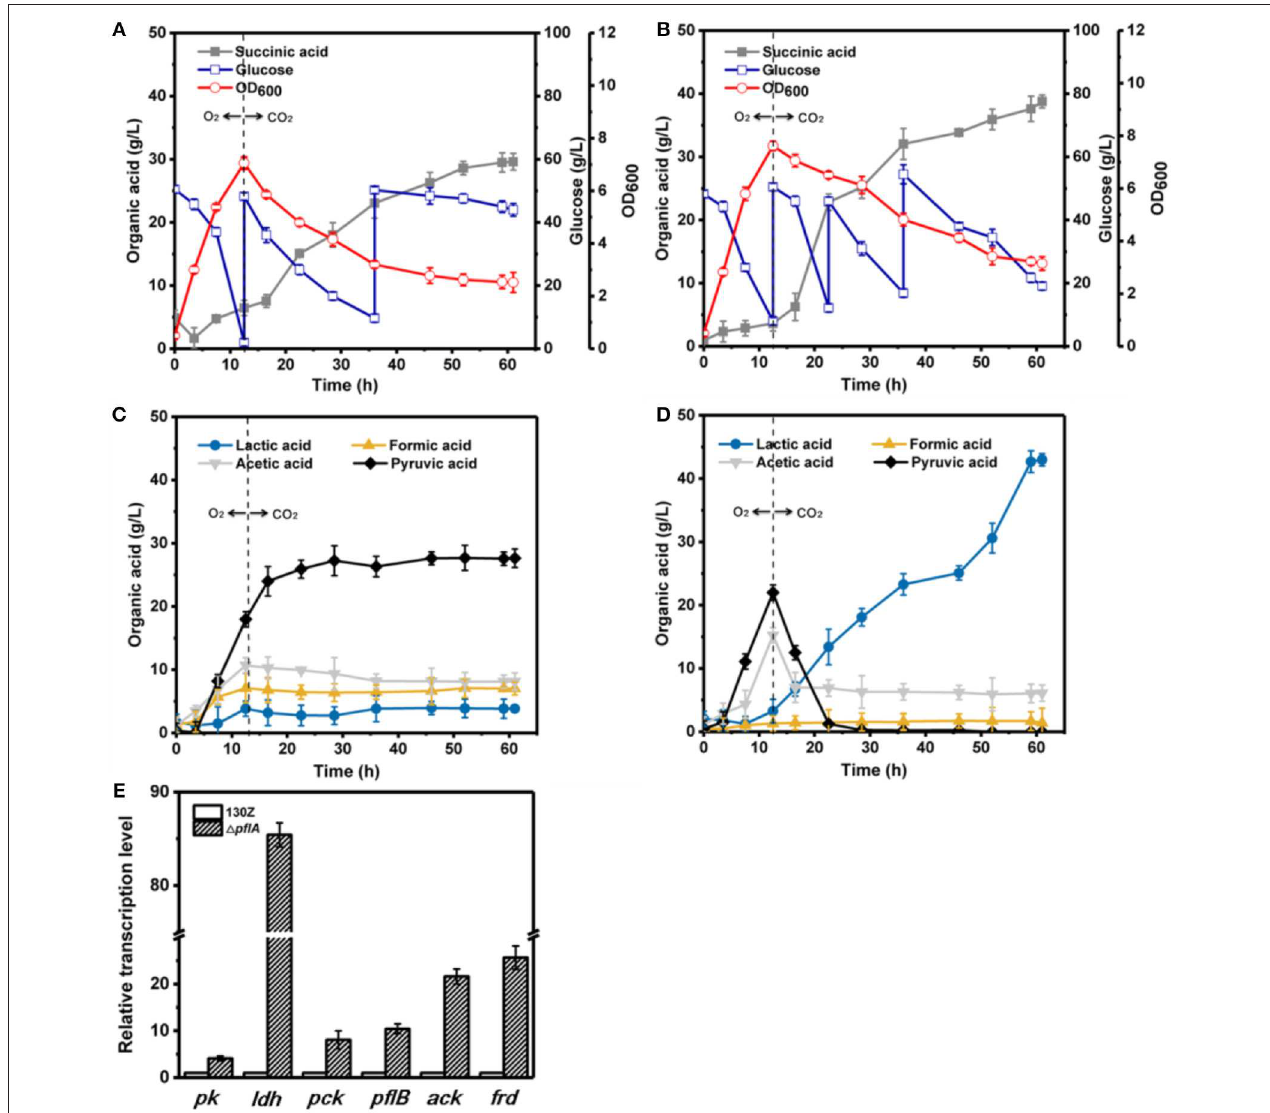
FIGURE 5 | Evaluation of different fermentation and metabolic parameters in the 130Z strain (A,C) compared to those of the 1 pflA strain (B,D) under aerobic–anaerobic dual-phase conditions. The bar graph (E) represents the expression levels of genes related to organic acid biosynthesis pathway.